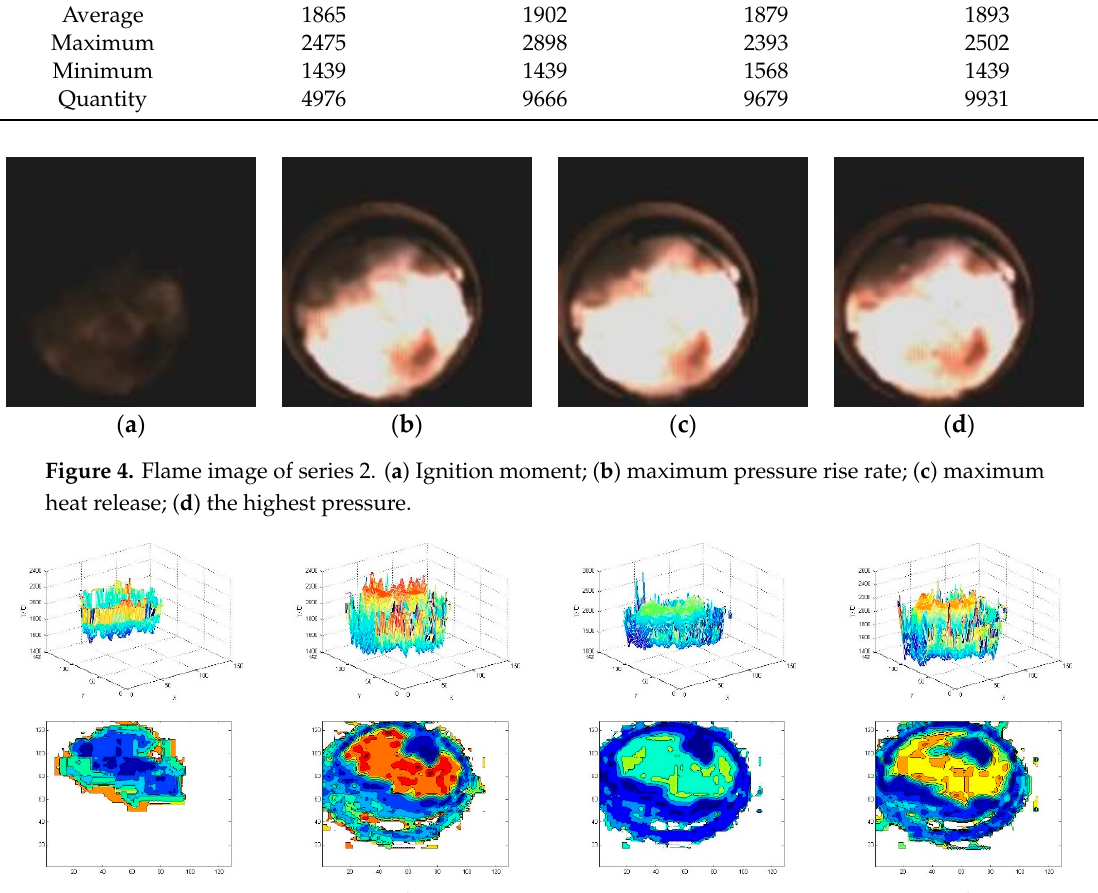
Figure 4. Flame image of series 2. ( a ) Ignition moment; ( b ) maximum pressure rise rate; ( c ) maximum heat release; ( d ) the highest pressure.